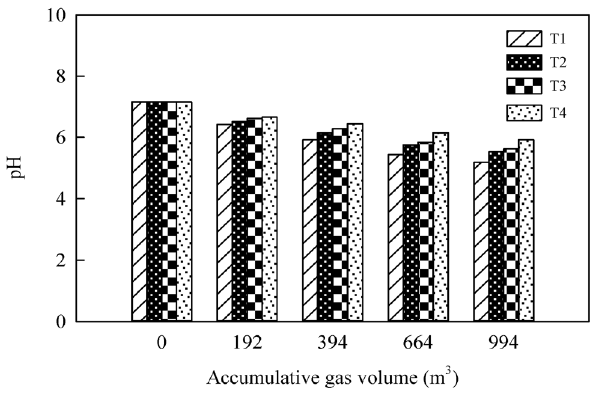
Figure 5: Inorganic S in vermicompost and control during hydrogen sul fi